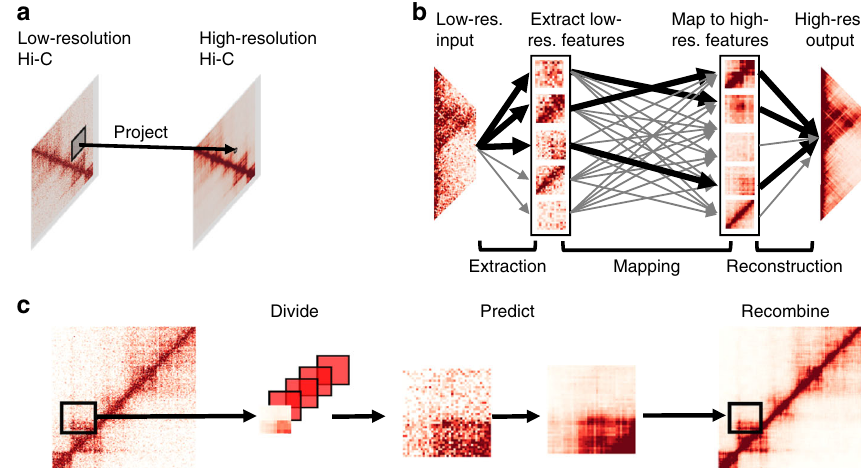
Fig. 1 Overview of the HiCPlus pipeline. a HiCPlus leverages information from surrounding regions to estimate contact frequency for a given point in a Hi-C interaction matrix. b Conceptual view of the network structure in HiCPlus: regional interaction features (e.g., loops, domain borders) are learned using values at each position in the high-resolution matrix as the response variable and using its neighbouring points from the low-resolution matrix as the predictors. c HiCPlus divides the entire Hi-C matrix into small square samples and enhances them separately. After each block of interactions are predicted, those blocks are merged into chromosome-wide interaction